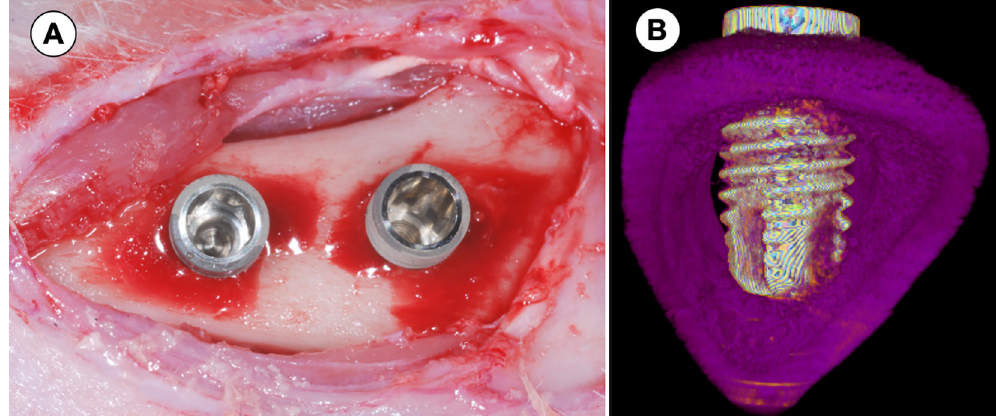
Figure 1- Implant installation on the rabbit tibia. A - Two implants installed on the right tibia with dissection of soft tissue and periosteum. B - Schematic 3D model of transverse tibia section showing the implant installed in cortical